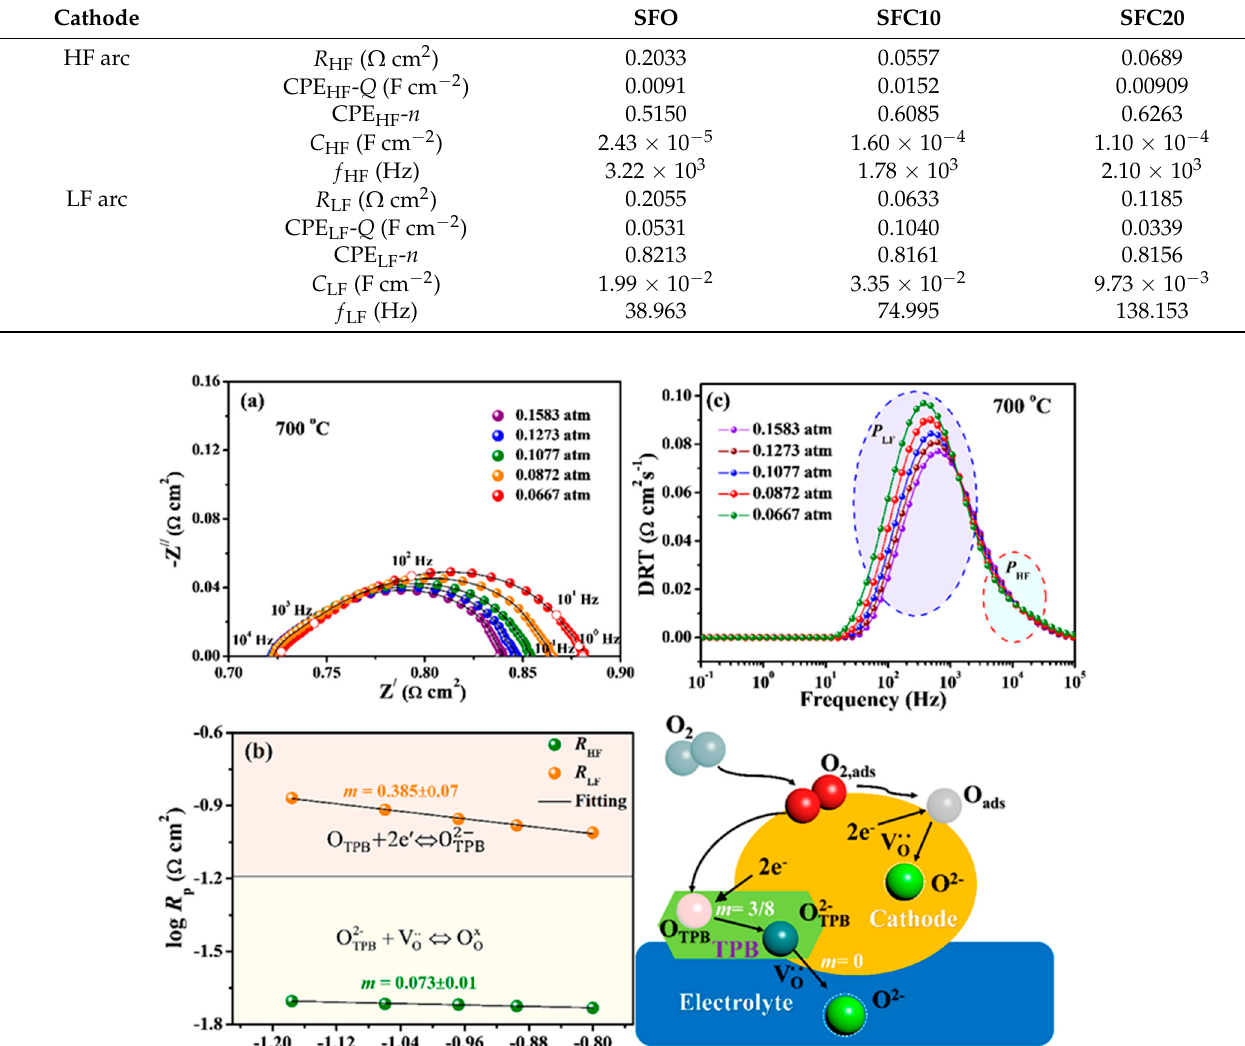
Table 2. Equivalent circuit fitting results of the impedance spectra for the SFC x electrodes at 700 ◦ C.